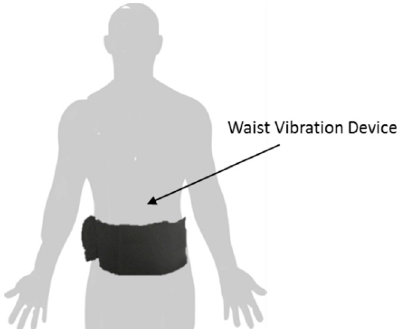
Figure 16. Illustration of a user wearing the continuous somatosensory cueing device developed by Gonçalves et al. Four haptic drivers/vibration units were placed inside the waistband and arranged with an intermediate spacing (15 cm) that facilitated a 76 to 110 cm waist size, while providing the stimulation to the navel, spine, right side and left side of the waist. The waistband was designed to be robust enough to support the electronics (overall weight of 458 g).